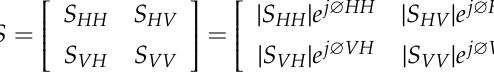
5 of 28 Figure 2. Structure of neural networks in our segmentation method. Blue and green blocks donate encoder parts, which consist of multi convolution layers, here we used depthwise separable convolution, dilated convolution and standard convolution as filter kernel, respectively. Purple-red